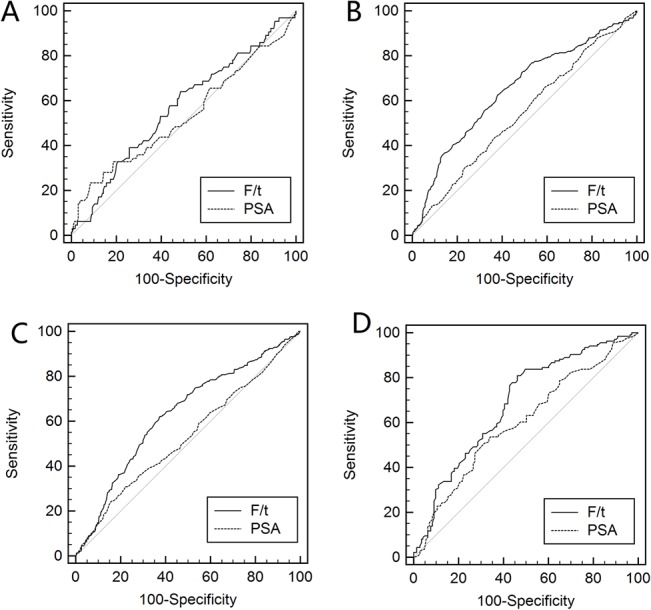
ROC curves of %fPSA and PSA for high-grade PCa.ROC curves of %fPSA and PSA in predicting high-grade prostate cancer for patients aged (A) 50–59 years; (B) 60–69 years; (C) 70–79 years; and (D) 80–89 years with a PSA level of 4.0–10.0 ng/ml.